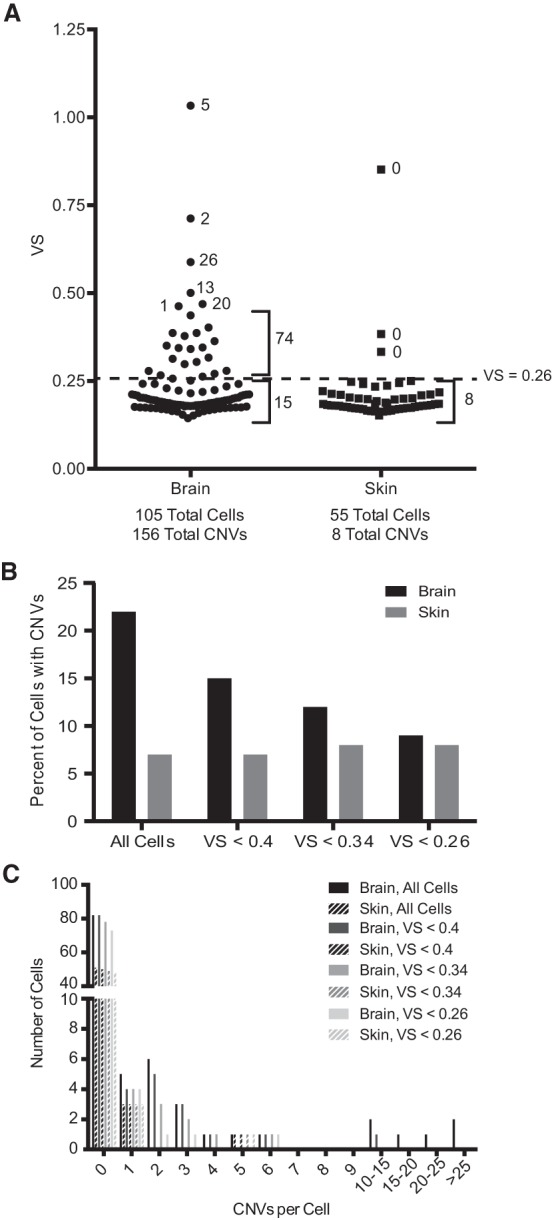
Relationship between variability score and CNV prevalence. (A) The variability scores for all brain and skin cells sequenced. The number adjacent to a given point or group of points indicates the total number of CNVs identified in that cell or group of cells. The dashed line indicates a VS cutoff of 0.26. (B) The percentage of brain and skin cells harboring at least one megabase-scale CNV using different VS cutoffs to exclude cells from analysis. (C) The distribution of the total number of megabase-scale CNVs per cell in brain and skin using different VS cutoffs to exclude cells from analysis.